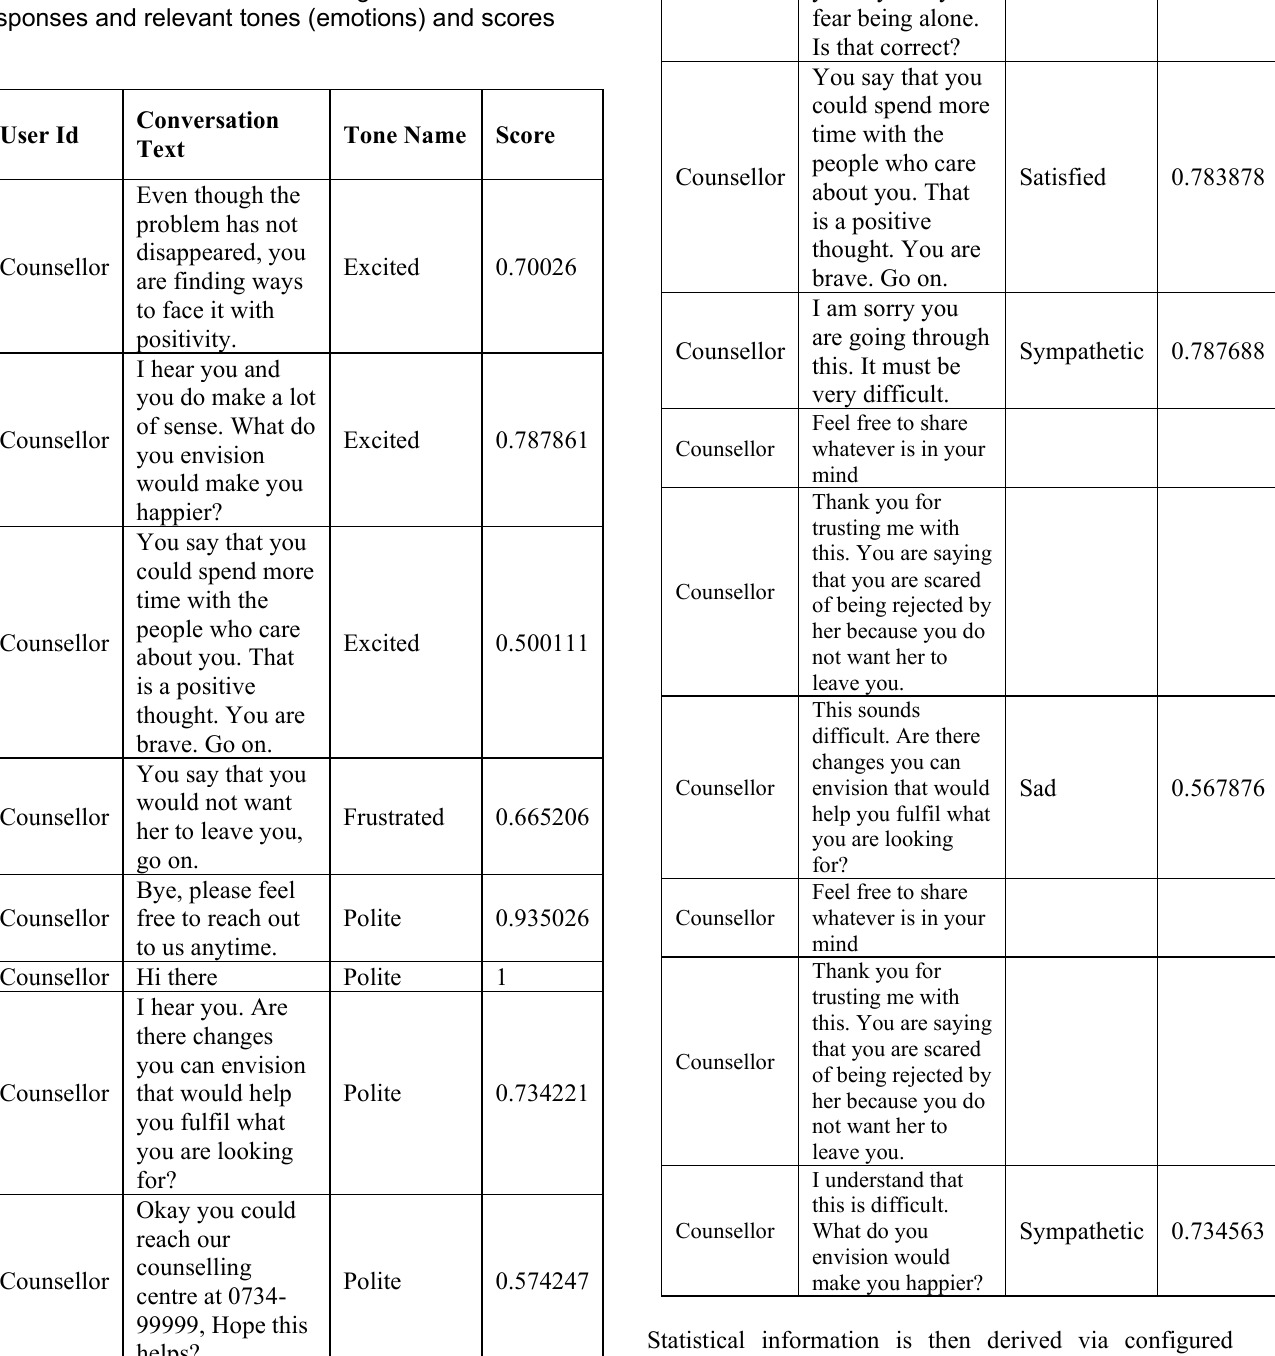
Table 18. Test results showing Counsellor responses and relevant tones (emotions) and